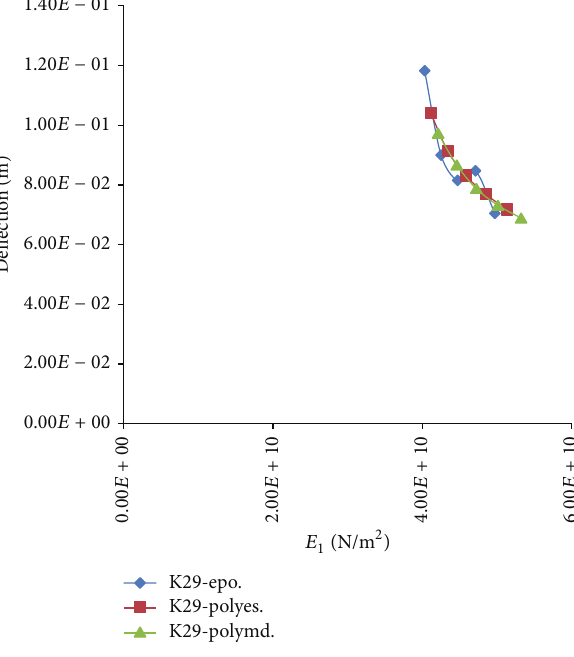
Figure 15: Effect of longitudinal modulus of elasticity on leaf spring deflection of various composite leaf springs based on fiber